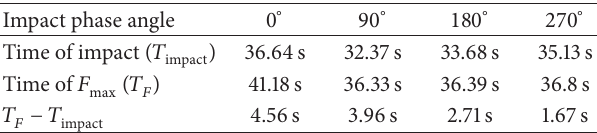
Table 2: Impact time and maximum hydrodynamic force of different phase